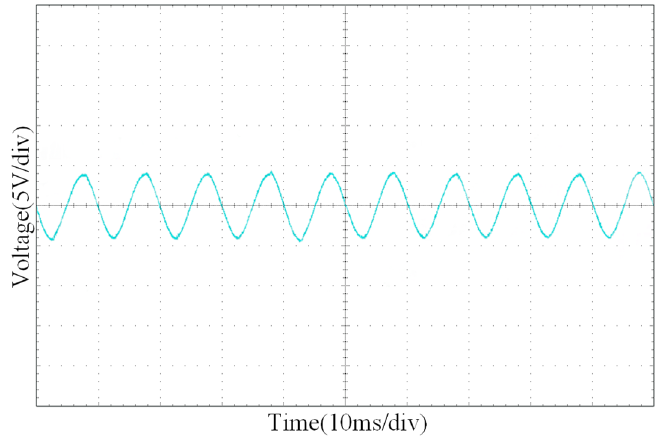
Figure 20. Output voltage ripple waveform of bridgeless PFC.